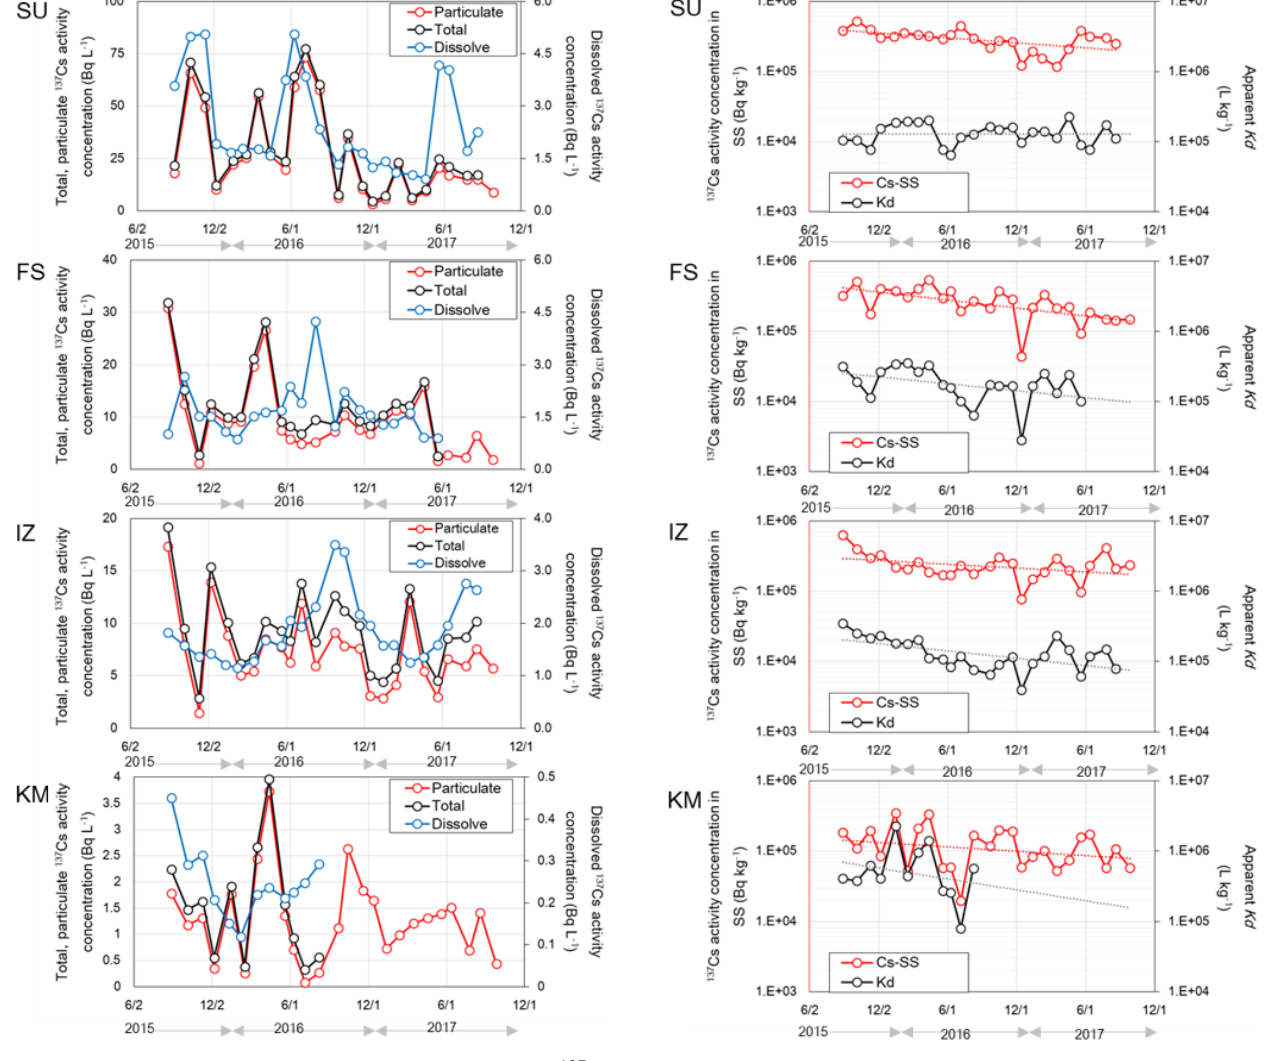
Figure 3. Temporal variations in 137 Cs activity concentration of suspended sediment (Cs-SS) and apparent distribution coeffi- cient K d in the different